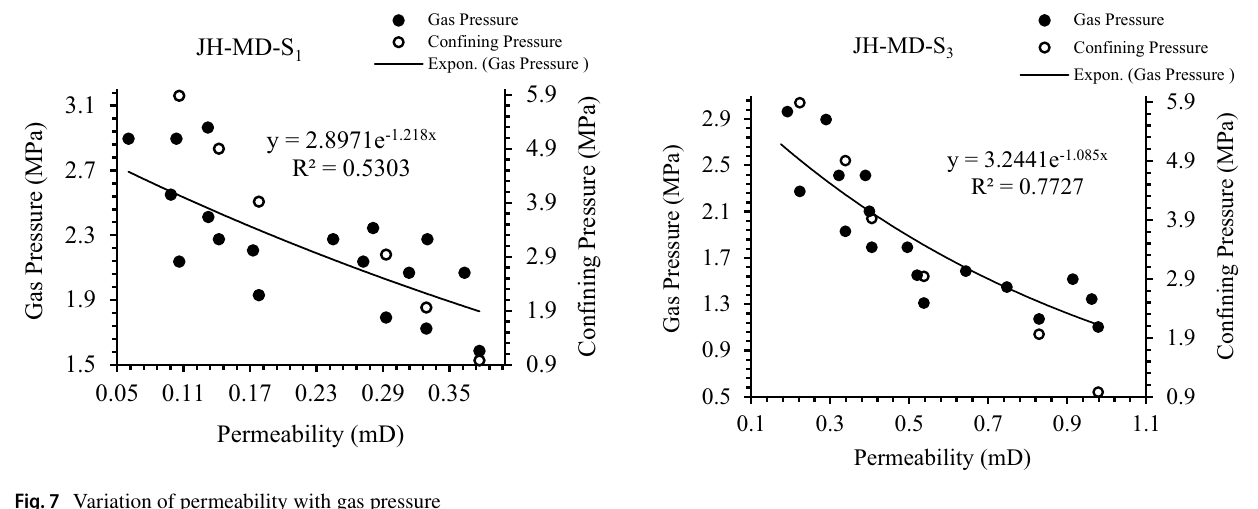
Fig. 9 Variation of permeability with gas pressure